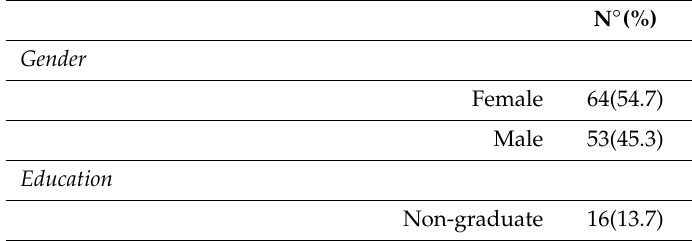
Table 1. Demographic data of participants and their distribution in technology use